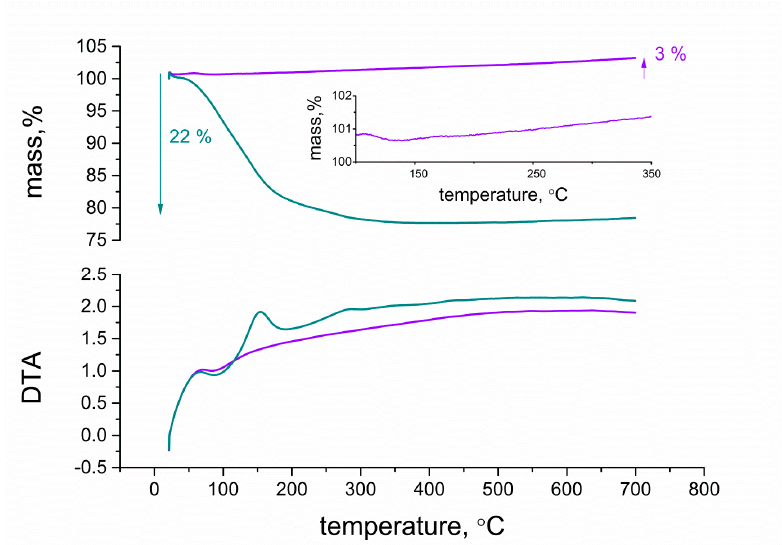
Figure 4. DTA/TG (Differential Thermal Analysis/ Thermogravimetry) diagrams of anhydrous (violet curves) and hydrous (blue curves) RuO 2 (upper curves: TG analysis, bottom curves: DTA).